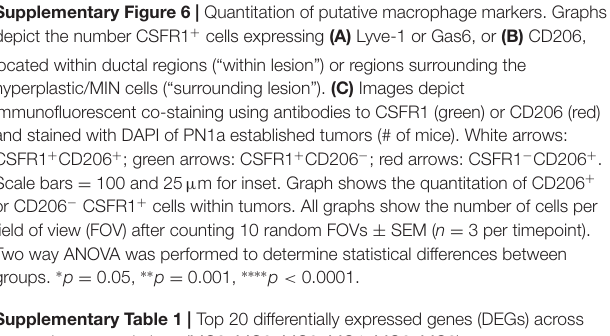
Supplementary Figure 1 | Strategy for defining immune cells in pre-invasive and invasive lesions. (A) Quality control filtering to eliminate cell doublets and contamination with mitochondrial DNA. (B) Principal component analysis identification of cell outliers at each time point. (C) UMAP distribution of immune cells at 8 and 16 weeks post-transplantation, demonstrating poorly represented clusters (filtered out). (D) Feature plot depicting Cd19 mRNA expression, which overlaps with Cd20 shown in Figure 1D . (E) Violin plot demonstrating the distribution of Cd14 across all clusters. (F) Graph depicts the number of cells in each cell type based on Cd14 (myeloid), Cd3e (T cells), Nkg7 (NK cells), Cd20 (B cells) mRNA expression.